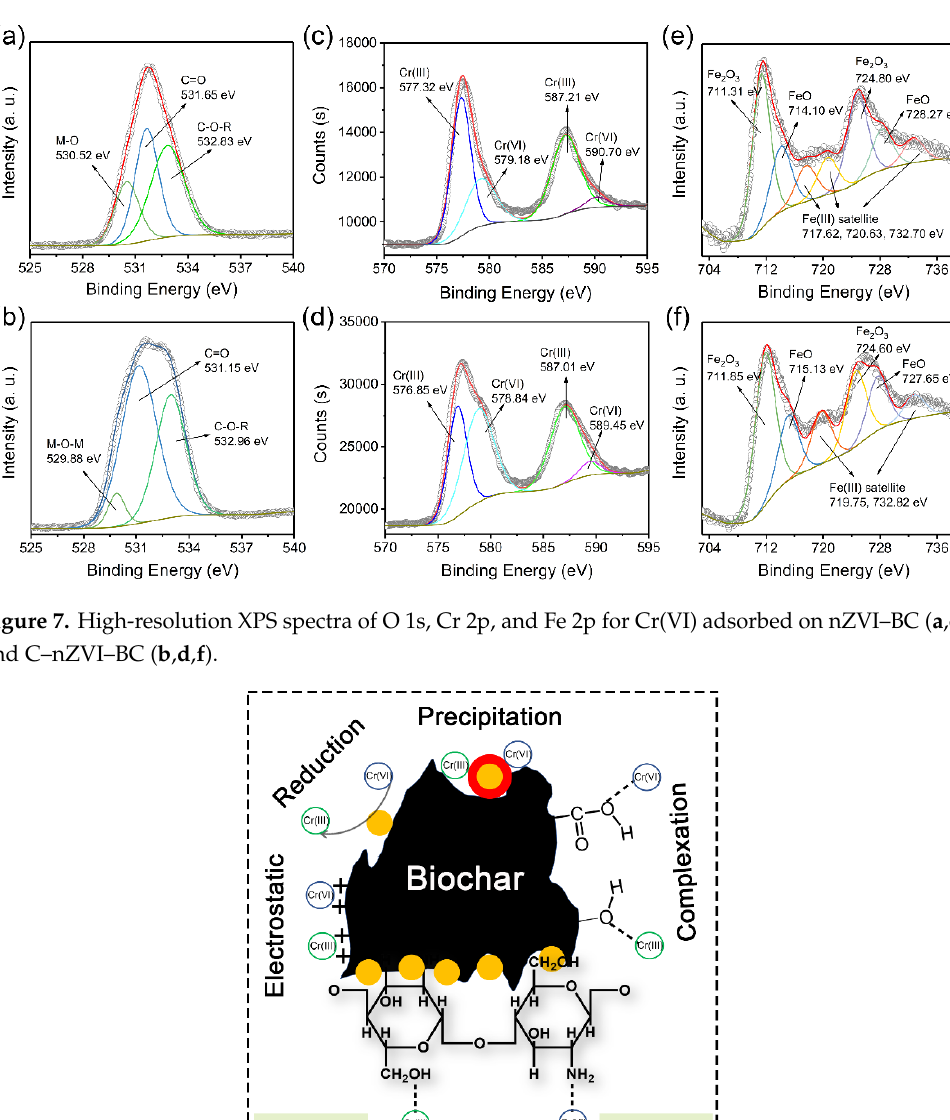
Figure 8. Mechanisms of Cr(VI) sorption by C – nZVI – BC.